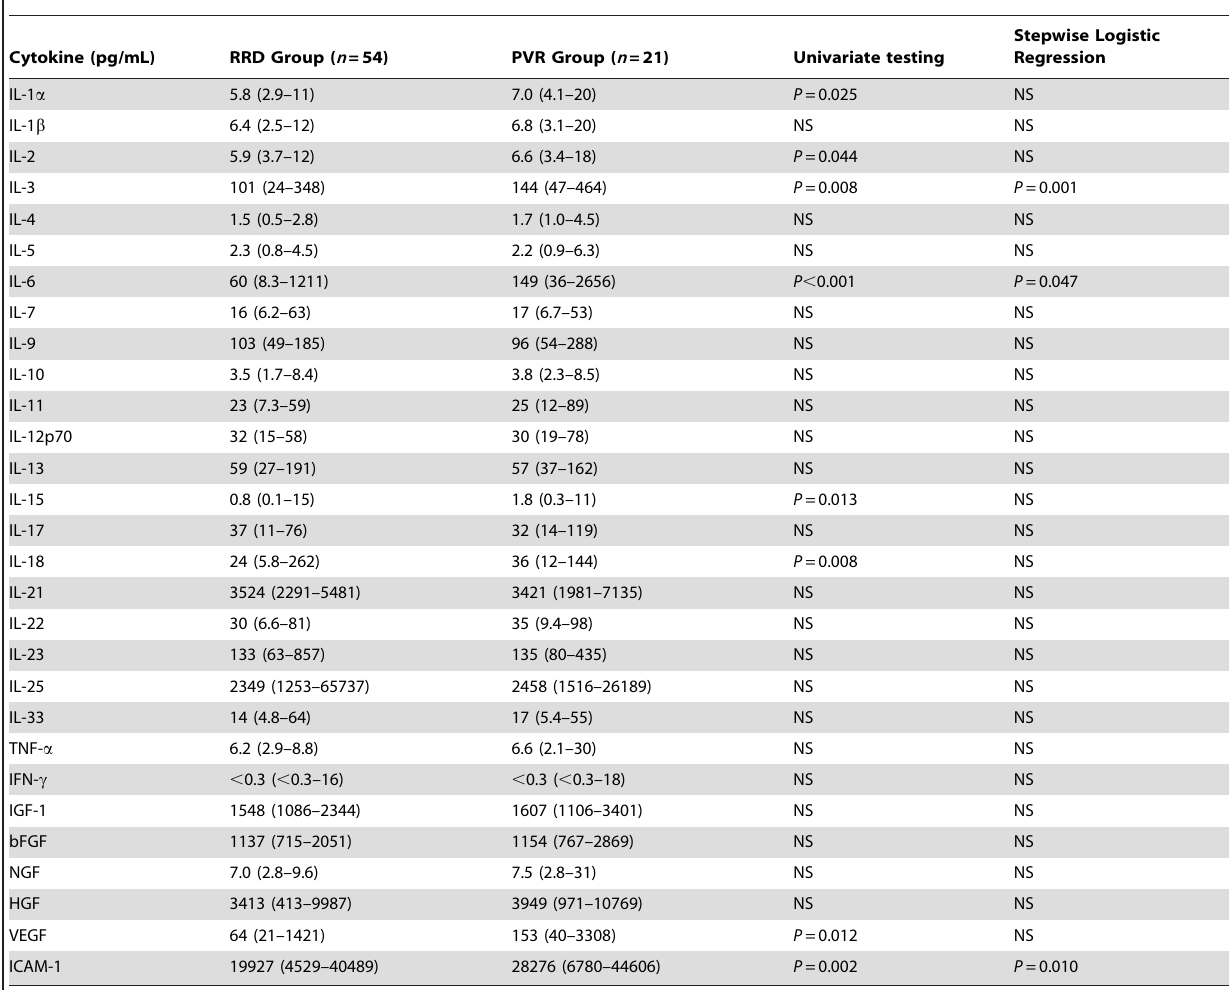
Table 2. Cytokine Levels and the Development of Postoperative